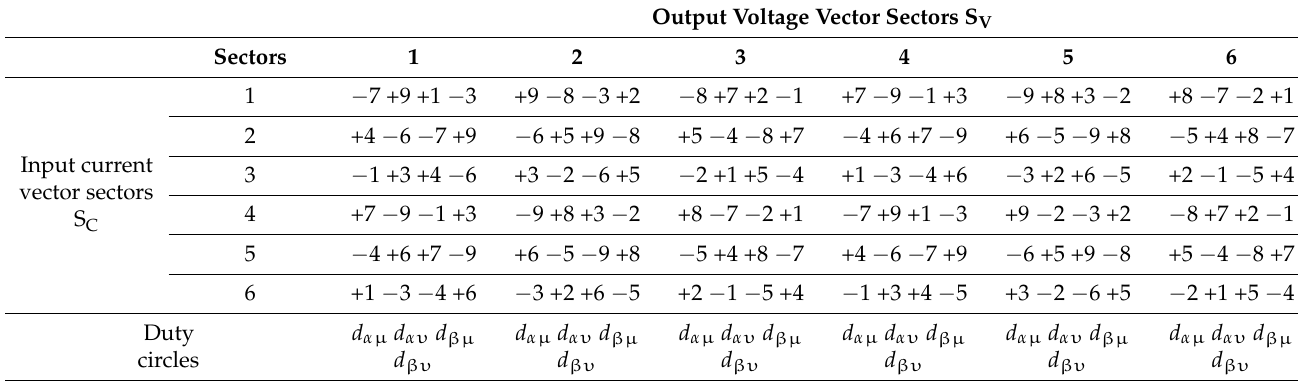
Table 3. Bidirectional switches combination logic. Figure 9. Graphical interpretation of switcher’s combination selection algorithm.